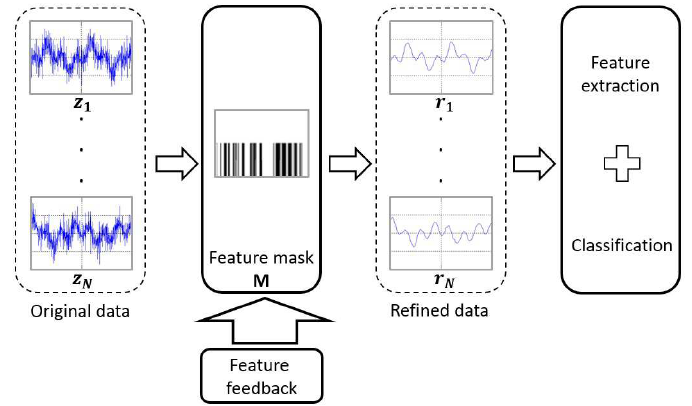
Figure 2. Vapor classification based on feature